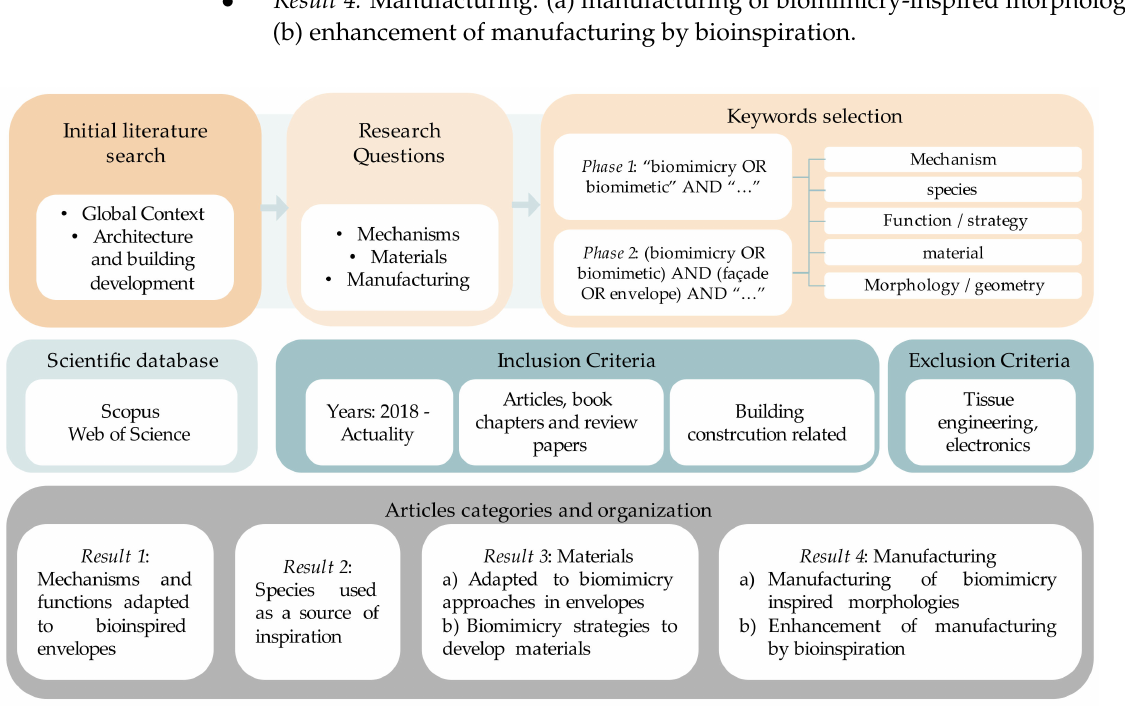
Figure 1. Research methodology proposed for the literature